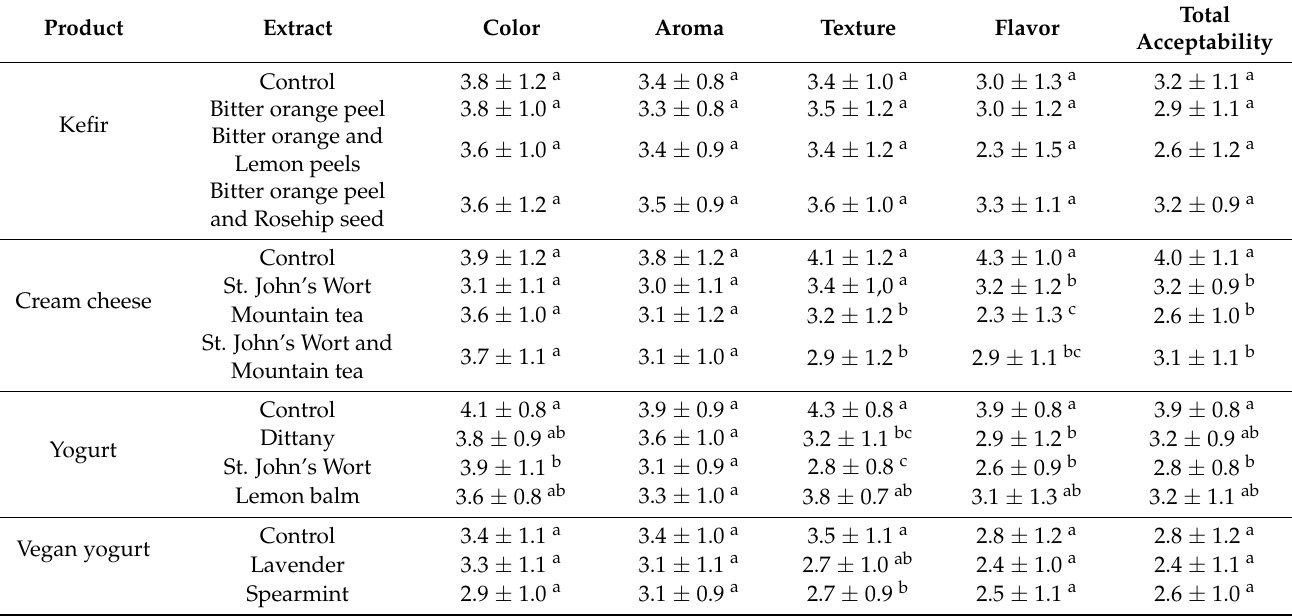
Table 7. Evaluation of color, aroma, texture and flavor of the fortified new dairy